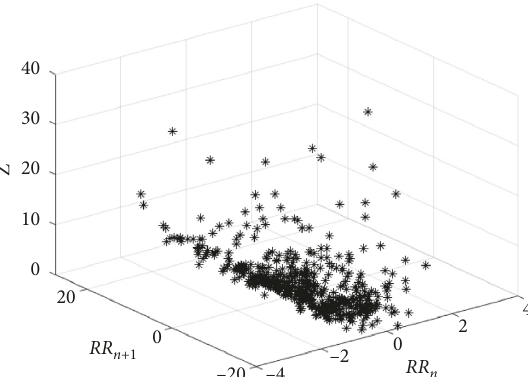
Figure 3: Three-dimensional Poincar´e plot of No. nsr001, derived from the normal sinus rhythm RR interval database.